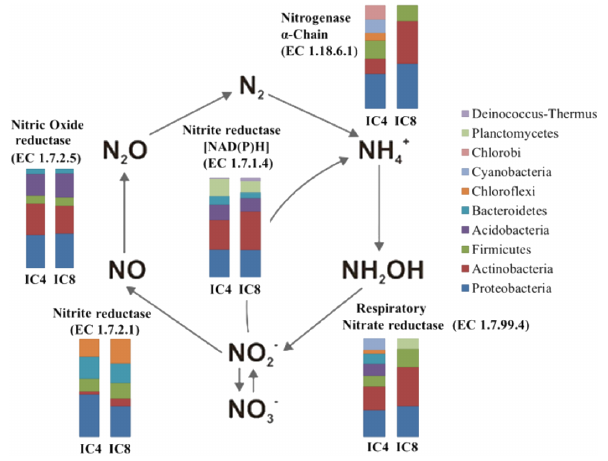
Figure 5. Phylogenetic distribution of the sequences related to ni- trogen metabolism within the IC4 and IC8 metagenomes.